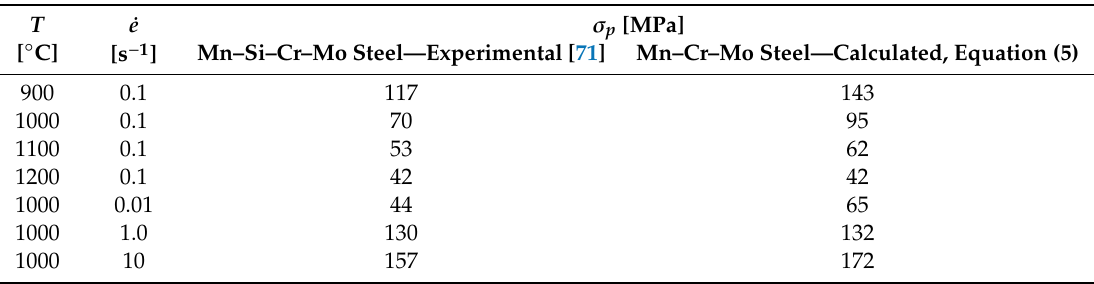
Table 2. Comparison of the peak stress values for two bainitic steel